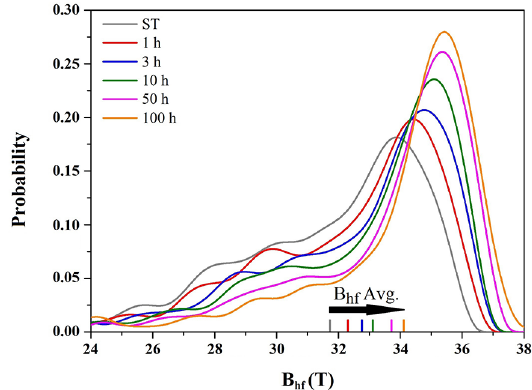
Figure 4. Probability distribution curves of the magnetic hyperfine field of Maraging-300 steel solution-treated and aged at 440°C for various